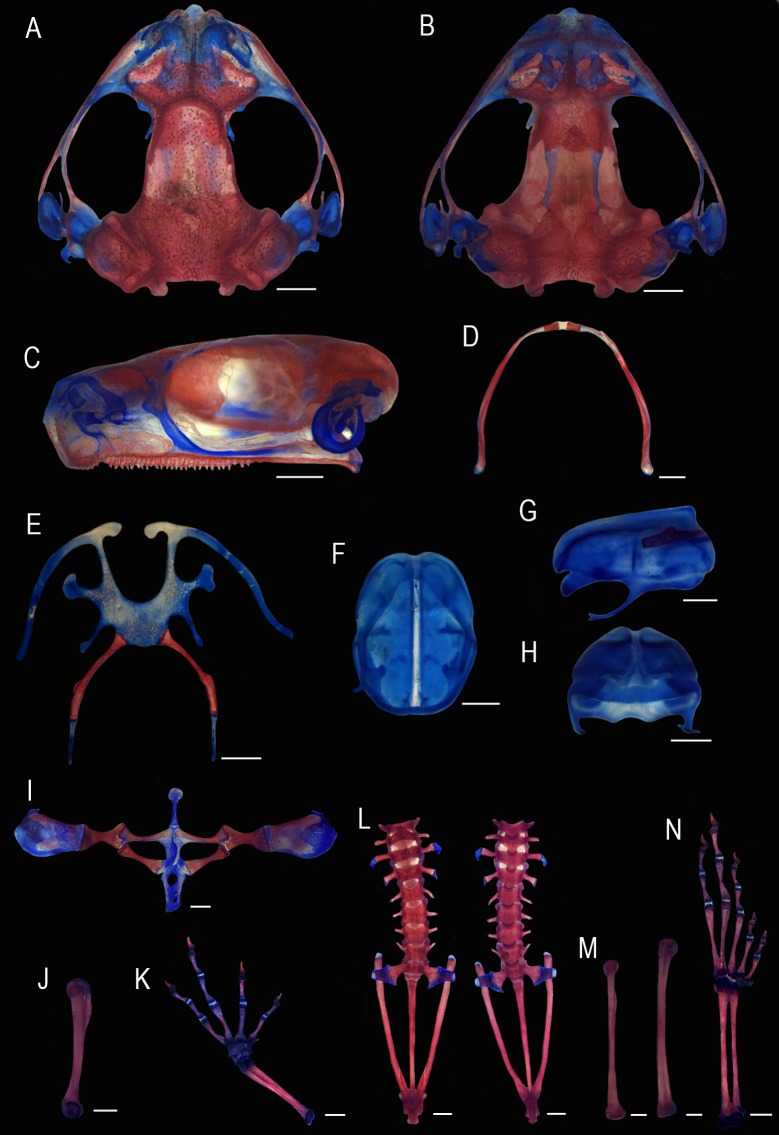
Skeletal morphology of Scinax fontanarrosai sp. n. (LGE 2040, male).Skull (A) dorsal, (B) ventral, and (C) lateral views. Mandible (D) dorsal view. Hyoid (E) ventral view. Larynx (F) ventral, (G) lateral, and (H) posterior views. Pectoral girdle (I) ventral view. Humerus (J) ventral view. Manus and radioulna (K) dorsal view. Vertebral column and pelvic girdle (L) dorsal and ventral views, respectively from left to right. Femur and tibiofibula, respectively from left to right (M) dorsal view. Pes (N) dorsal view. Scale bars = 1 mm.